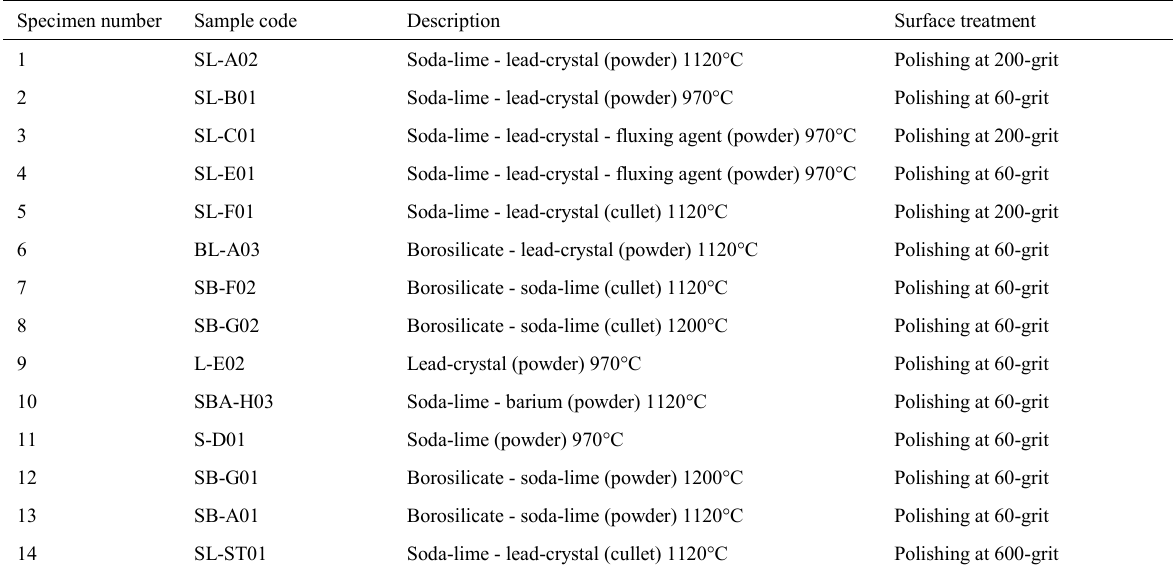
Table 5: Specimen